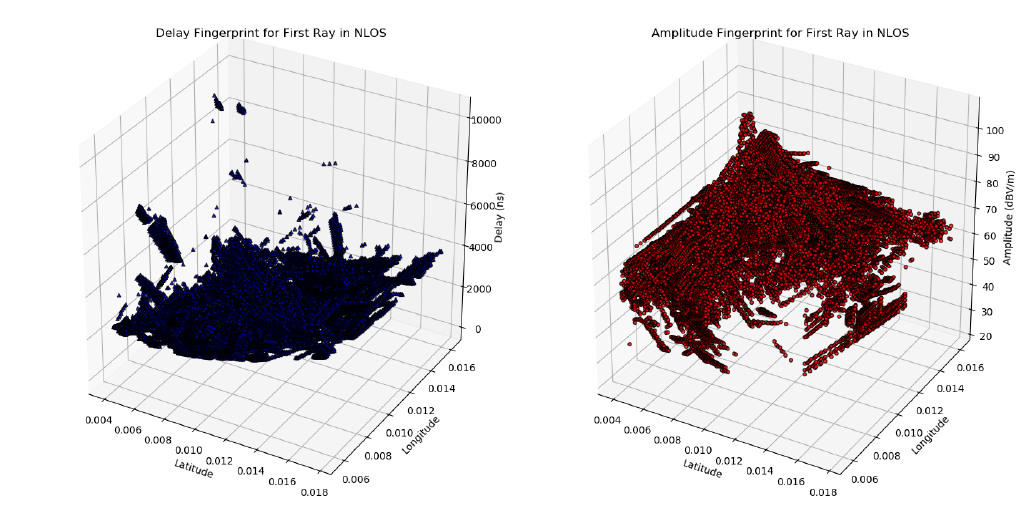
Figure 21. Multipath fingerprint of Ray 1 in Sensor